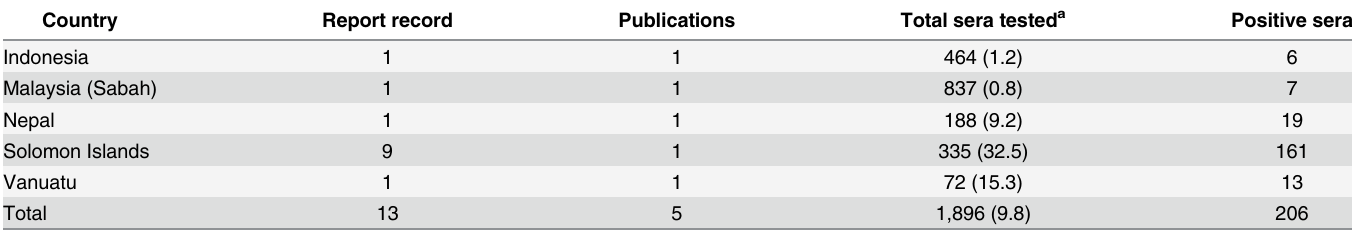
Table 3. Published human seroepidemiological reports since 1981 of Orientia tsutsugamushi -specific